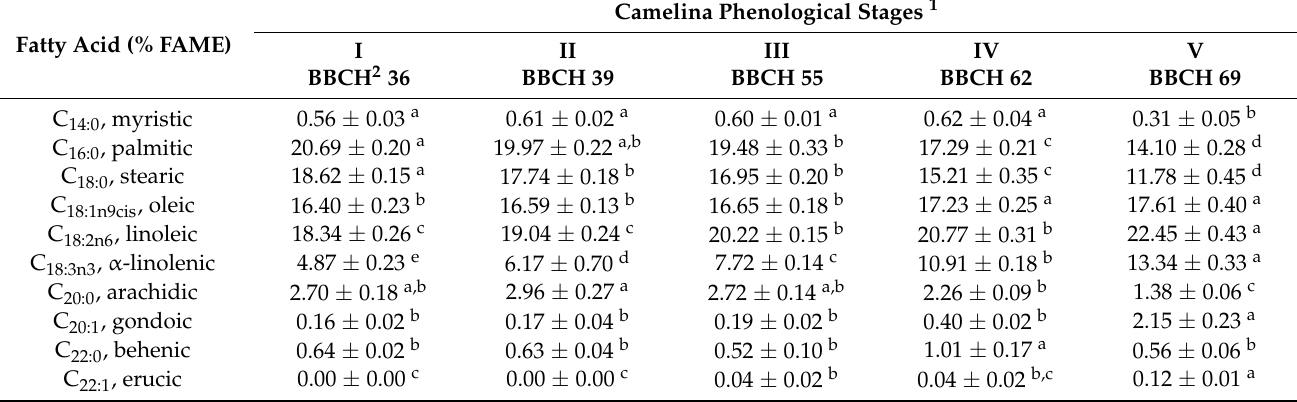
Table 5. Major fatty acids (% of Fatty Acid Methyl Esters, FAME) in Camelina fresh forage harvested during different phenological stages (mean ± standard error).